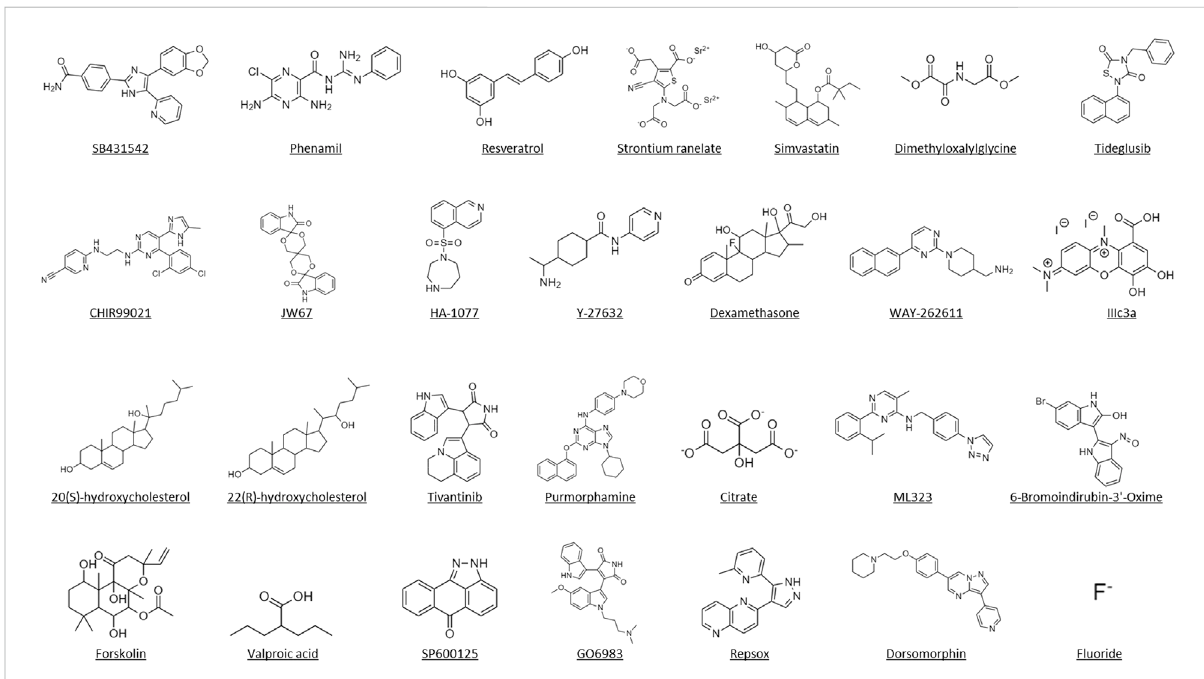
FIGURE 4 Molecular structures of the identi fi ed small molecules that have been investigated for in vitro and in vivo craniofacial and dentoalveolar tissue engineering.